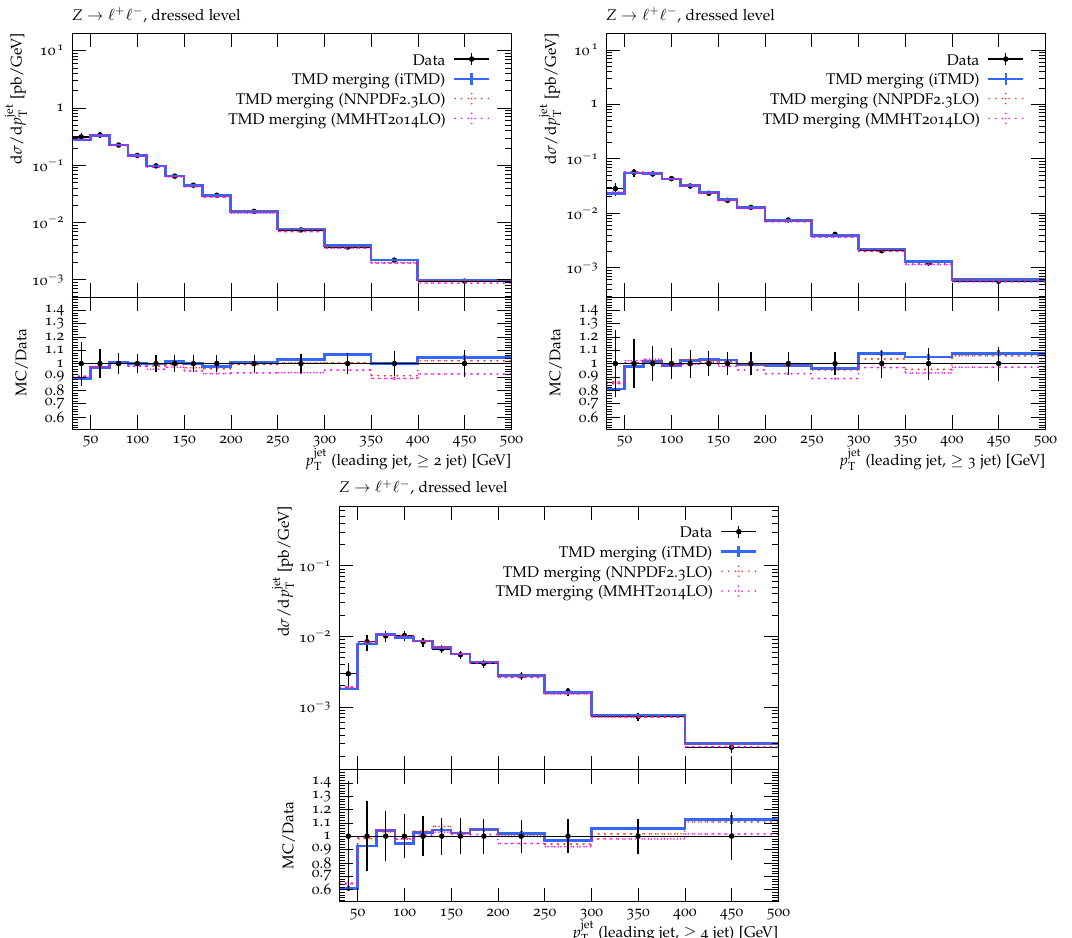
Figure 35 . Leading jet p T spectrum in inclusive Z + 2 (top left), 3 (top right), and 4 (bottom) jets: PDF